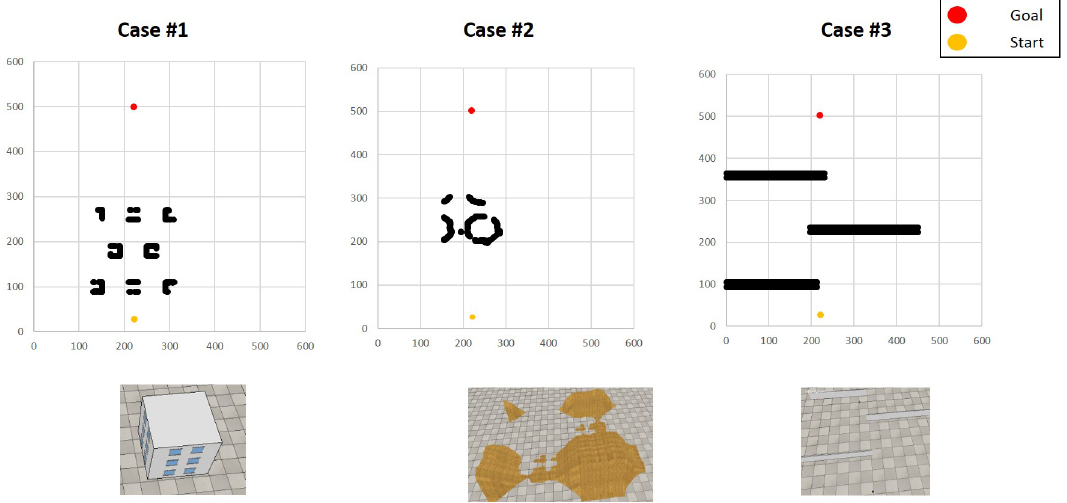
Figure 10. Evaluation